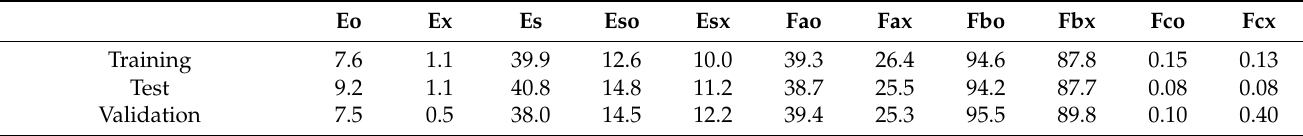
Table 2. Percentage of each label for three different sets.